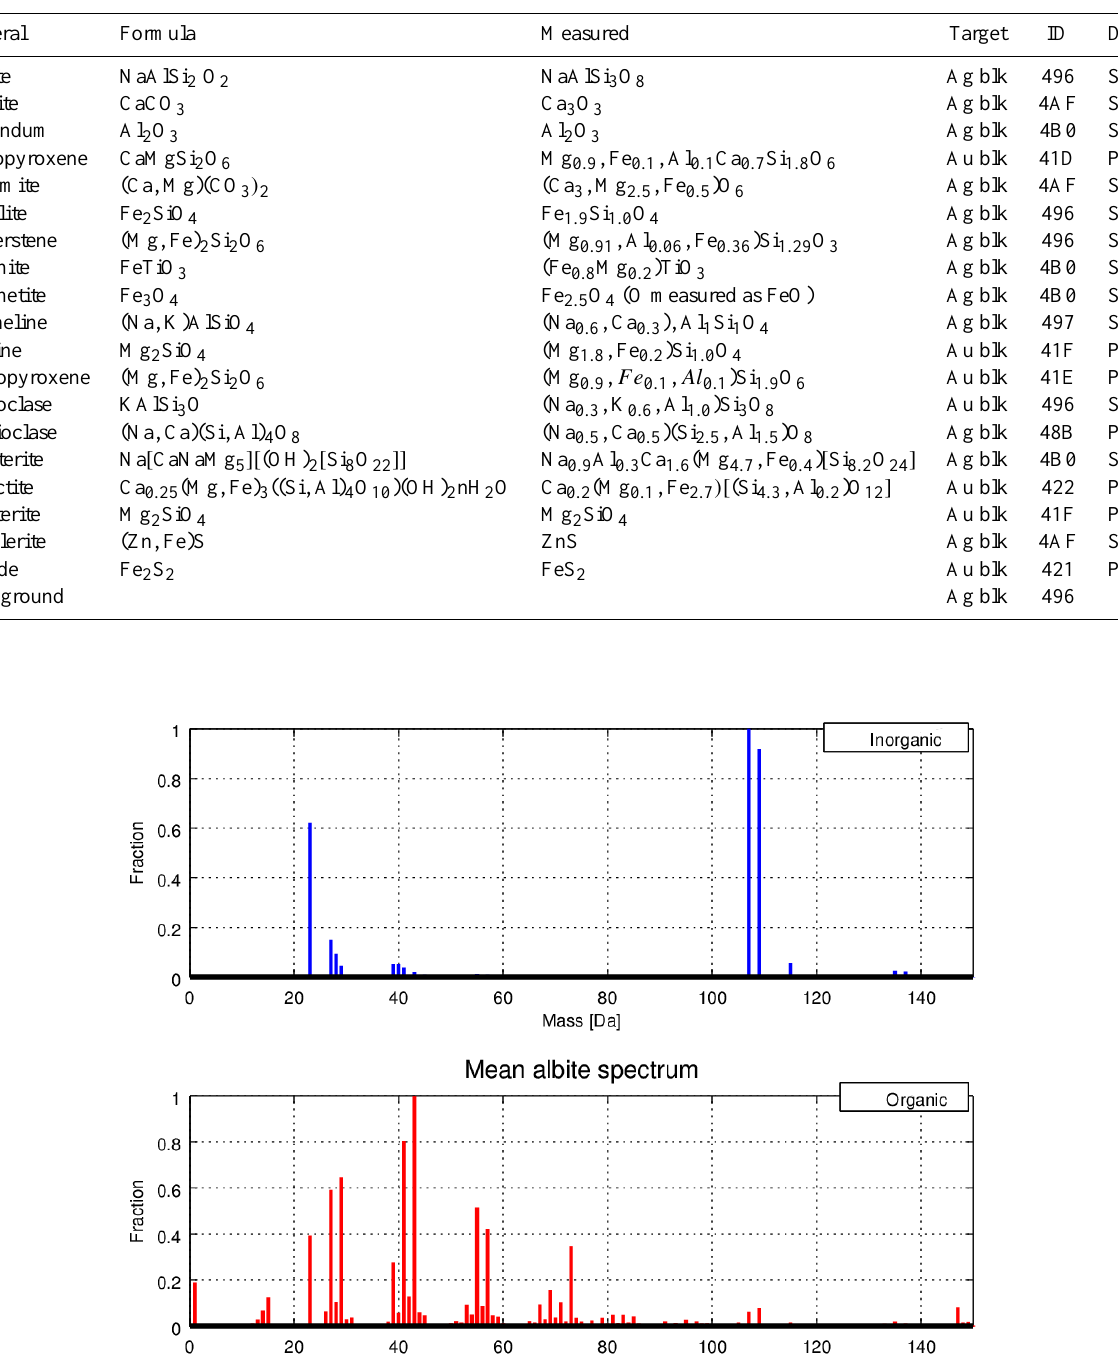
Table 2. Table showing the names, composition and substrates used for this investigation. Minerals are deposited on blank Ag or Au substrates either by suspension (S), by pressing (P) or heterogeneous (H), see last column. ID refers to substrate ID fond in the COSIMA data base. Fayalite is a heterogenous suspension. For calcite and dolomite, carbon was not measured. For richterite and smectite, hydrogen was not measured; for magnetite, oxygen was measured as FeO. Details on the measured compositions and target preparations are discussed in Krüger (2014).